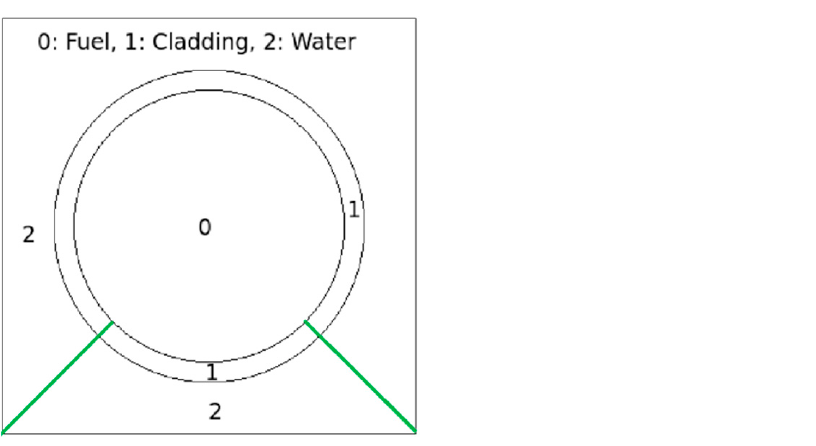
Figure 2. Construction of fuel pin cell with legend of the materials and the numbering of meta- cells. Structured layers serve mainly for IDT calculations. IDT (Integro-Differential Transport) is another flux solver of APOLLO3 ® based on the method of discrete ordinates and short characteristics (MOC), which is optimized for problems using Cartesian spatial meshes comprising homogeneous and heterogeneous cells. Structured layers describe a